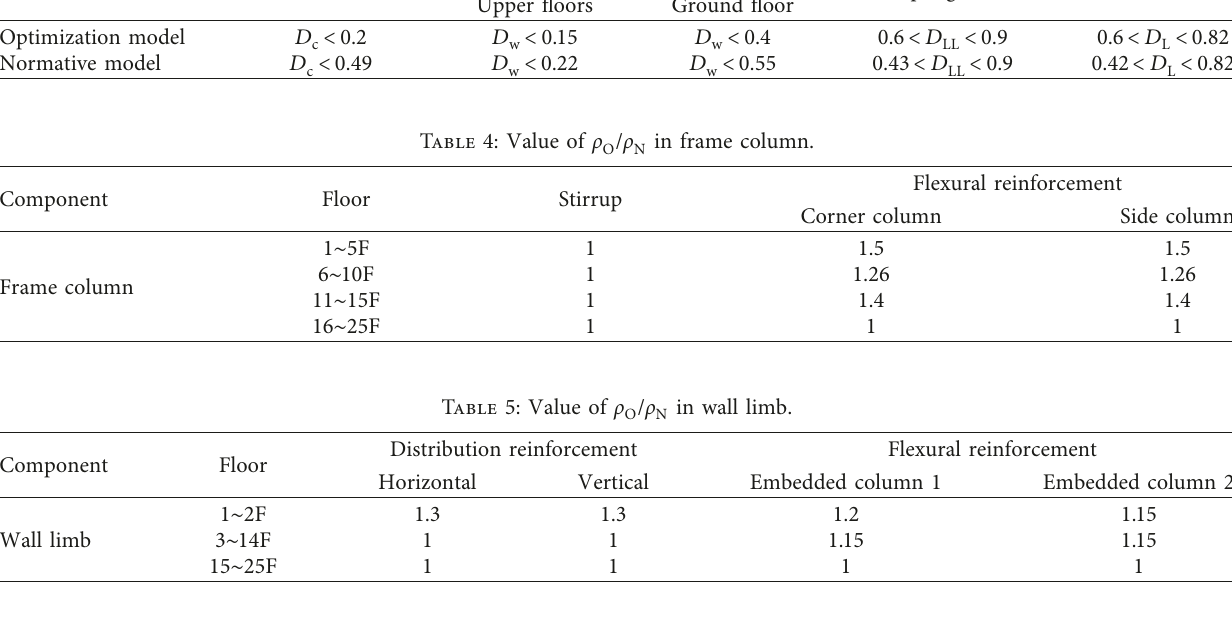
Table 3: Component damage scale of the two models.